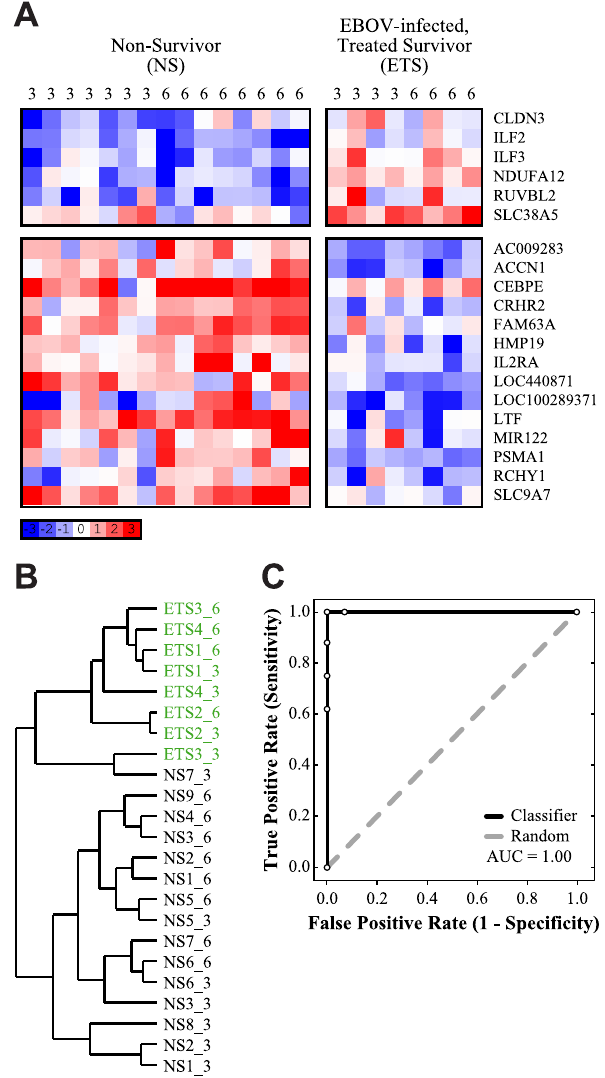
Figure 1. Identification of a small gene set is sufficient for classification of survival in EBOV-infected, anticoagulant- treated NHPs. ( A ) A heatmap depicting the gene expression values of 20 genes which were found to distinguish between ‘‘EBOV-infected, Treated Survivors’’ (ETS) and Non-Survivors (‘‘EBOV Only’’ and ‘‘EBOV- infect, Treated Non-Survivors’’;see Materials andMethods ). Thedays post- infection are labeled at the top of each column. Blue indicates down- regulation, and red indicates up-regulation, of genes compared to pre- infection baseline, white indicates no change in expression (scale indicated). Gene names are listed to the right. ( B ) A dendrogram depicting hierarchical clustering of individual samples, using the set of 20 genes (permutation test, one-tailed P , 0.0001). ETS samples areindicated in green; samples are labeled ‘‘groupX_Y’’, where X is the sample number and Y is the days post-infection. ( C ) A ROC curve depicting how accurately this gene setcan classify survivors andnon-survivors, based on leave-one-out cross-validation (AUC=1.00). This gene set is indicated in black, and a random ROC curve is indicated in grey.